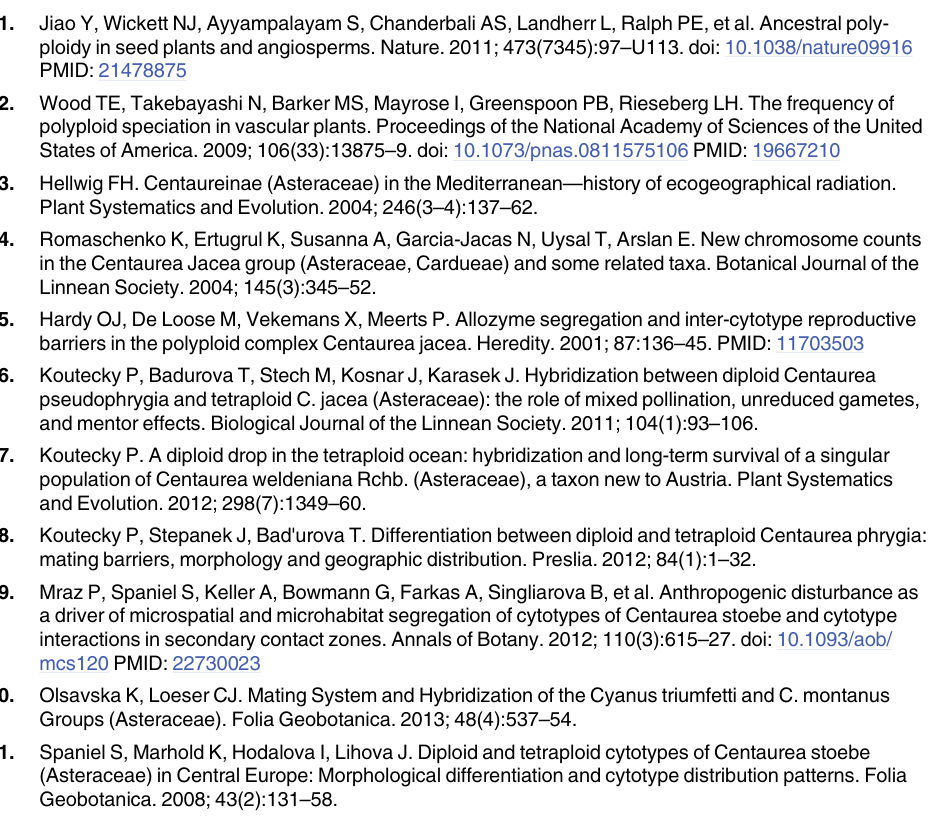
S3 Fig. Photographs of the three studied taxa. From left to right: C . aspera (diploid), C . × sub- decurrens (triploid) and C . seridis (tetraploid); habitat (upper); location: study area (red trian-